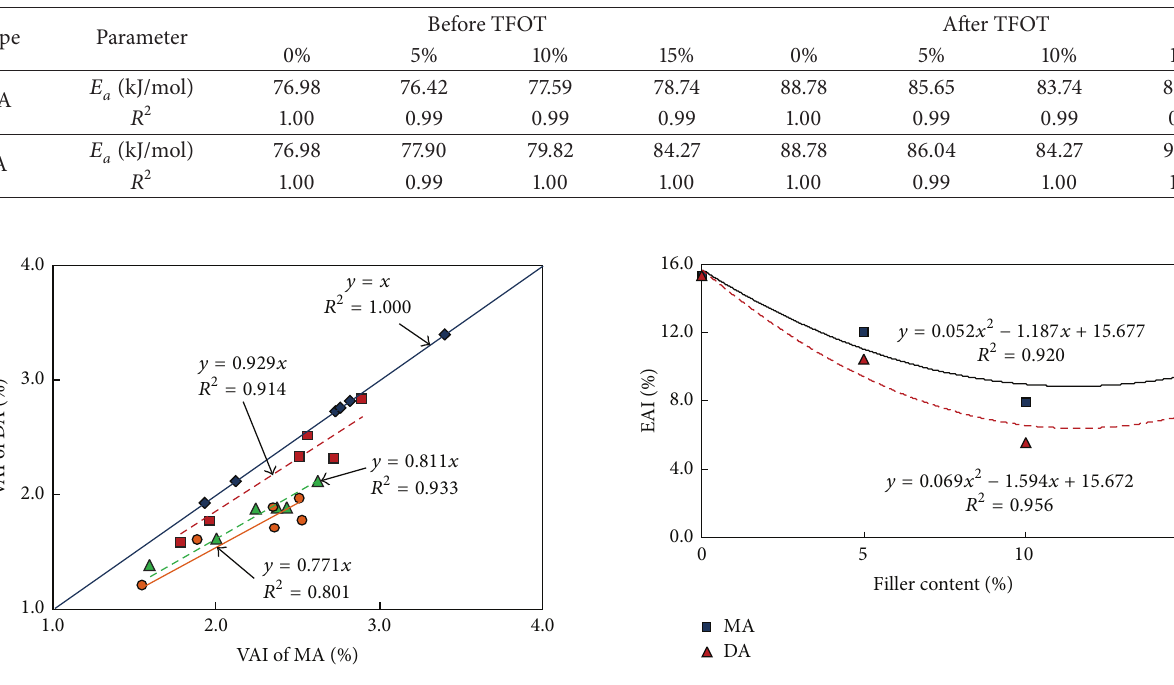
Table 6: Results of activation energy 𝐸 𝑎 .